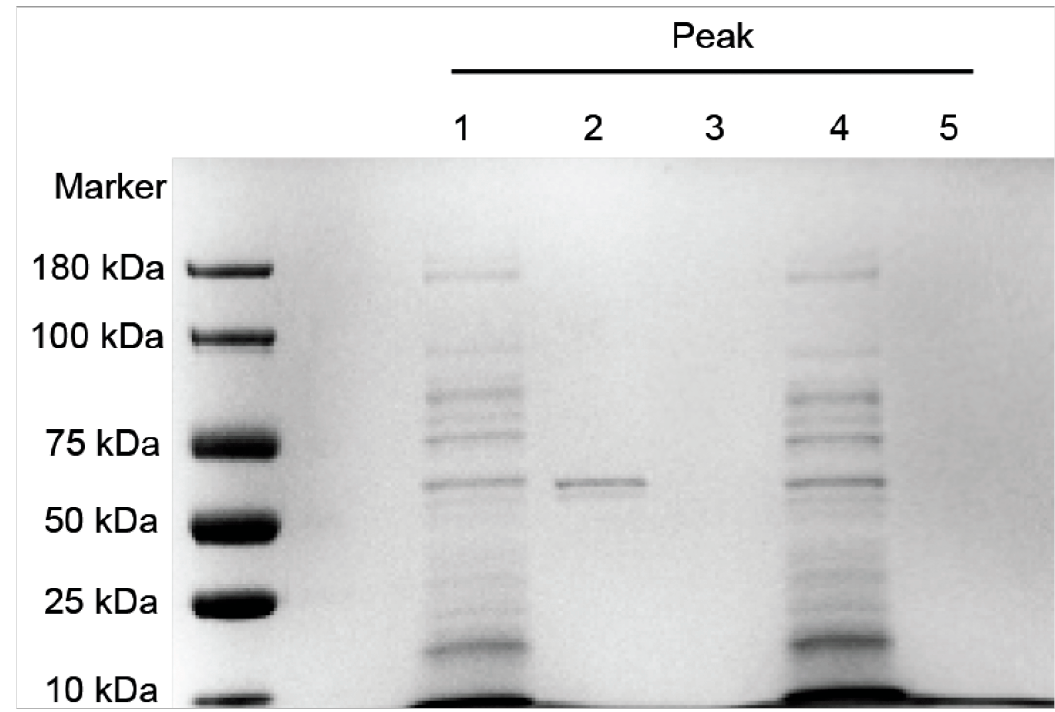
Figure 2. SDS-PAGE of the isolated fractions.